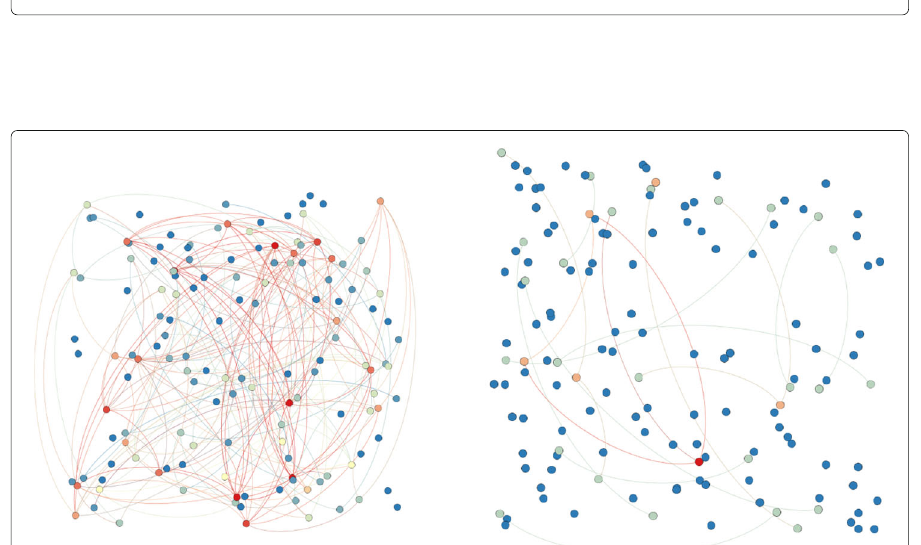
Fig. 10 Private proteins networks: the left one corresponds to the minimum combined score (150), the right one corresponds score values greater than 500. Warm colours for nodes indicate hight degree centralities. Warm colours for edges indicate hight weights